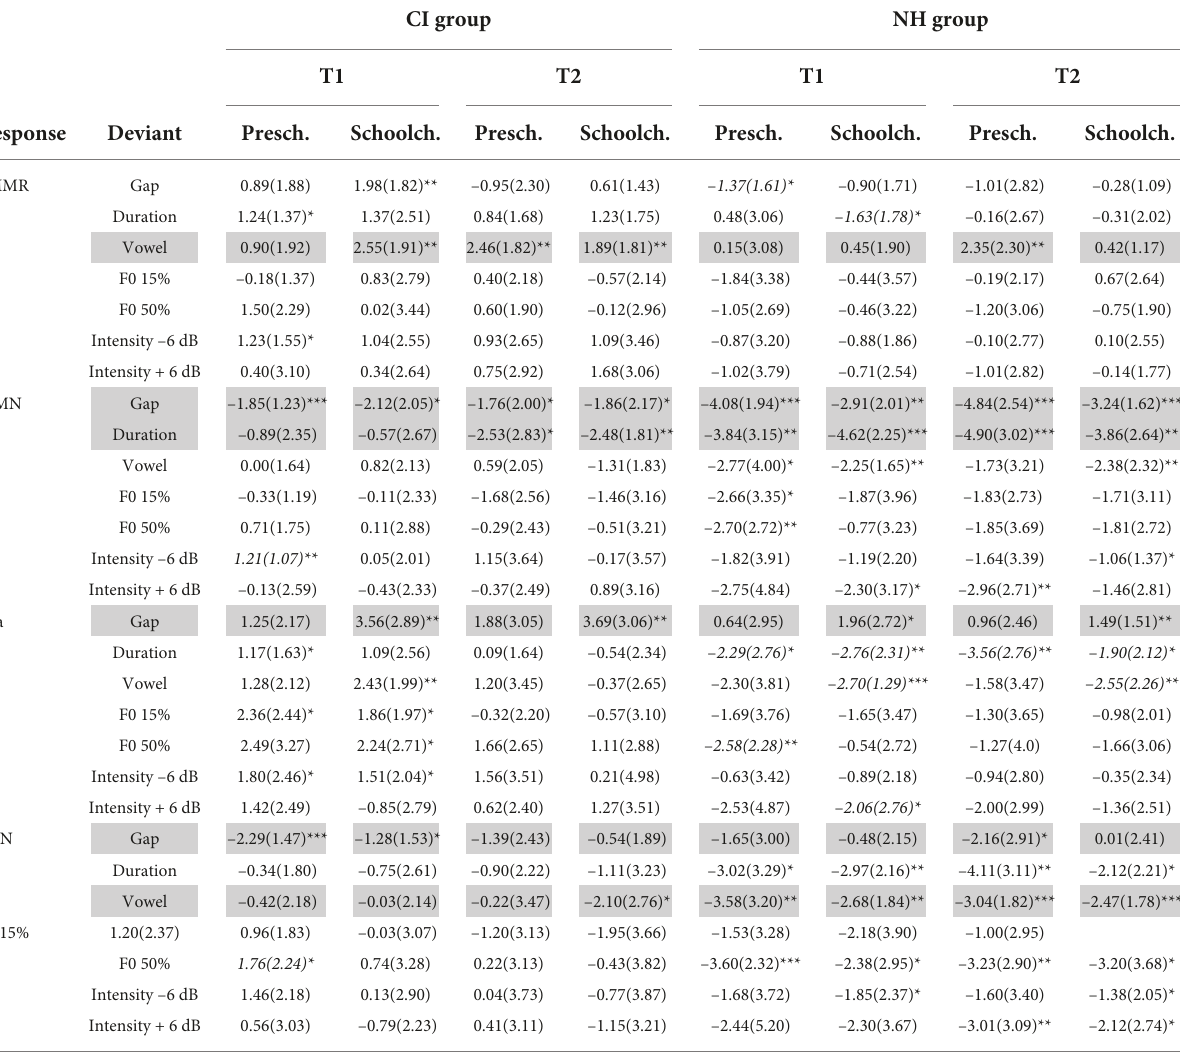
TABLE 4 Response